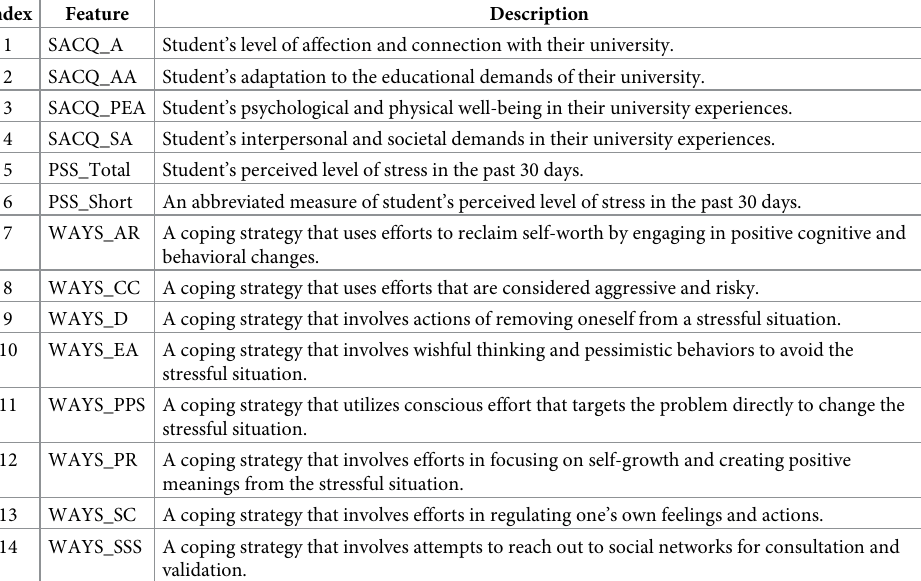
Table 2. Input features for the classification models.